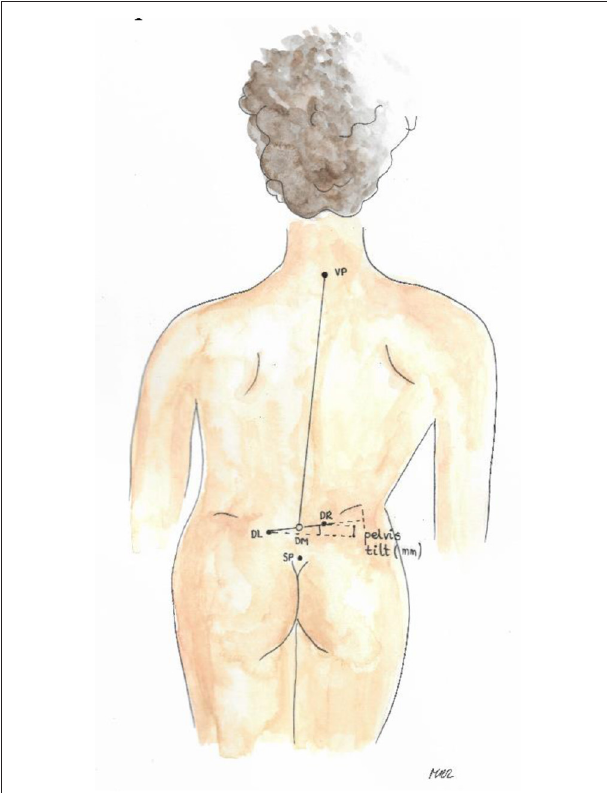
FIGURE 4 | Pelvic skewness.